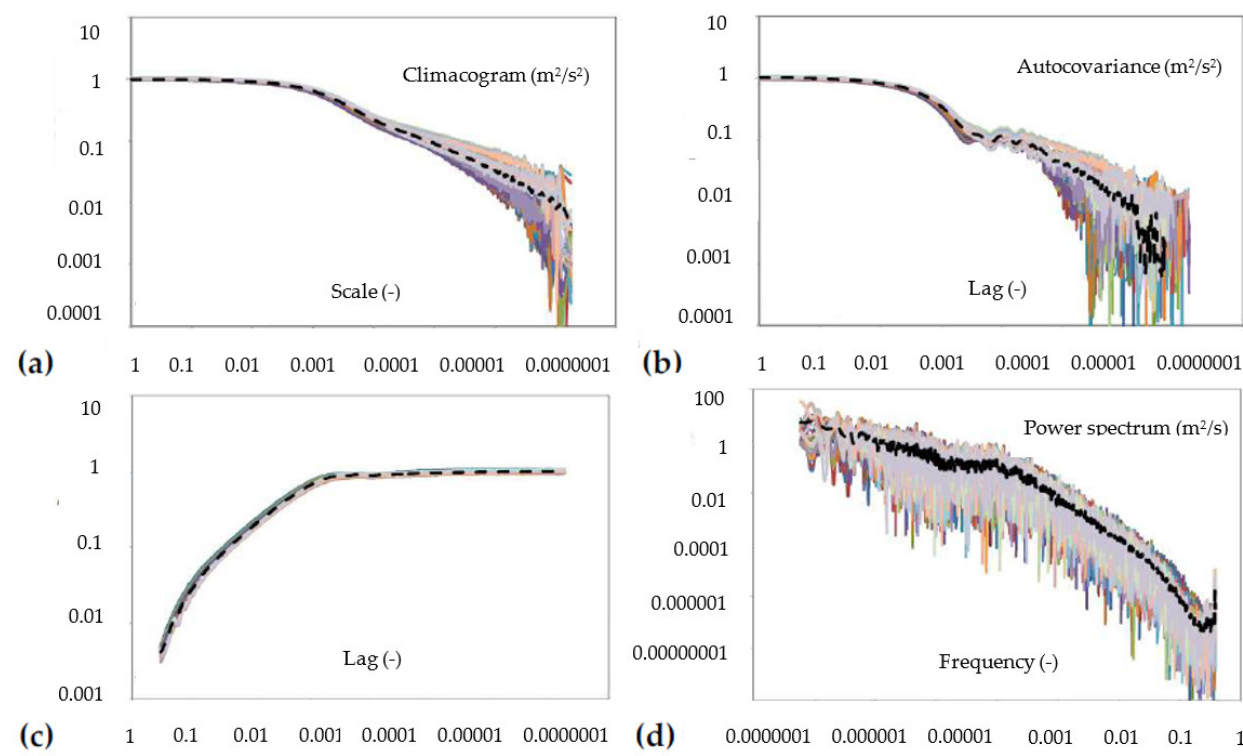
Figure 4. Standardized second-order stochastic metrics for the longitudinal velocity of the grid-turbulence dataset: ( a ) climacogram; ( b ) autocovariance; ( c ) variogram; ( d ) power spectrum. Source: [56].